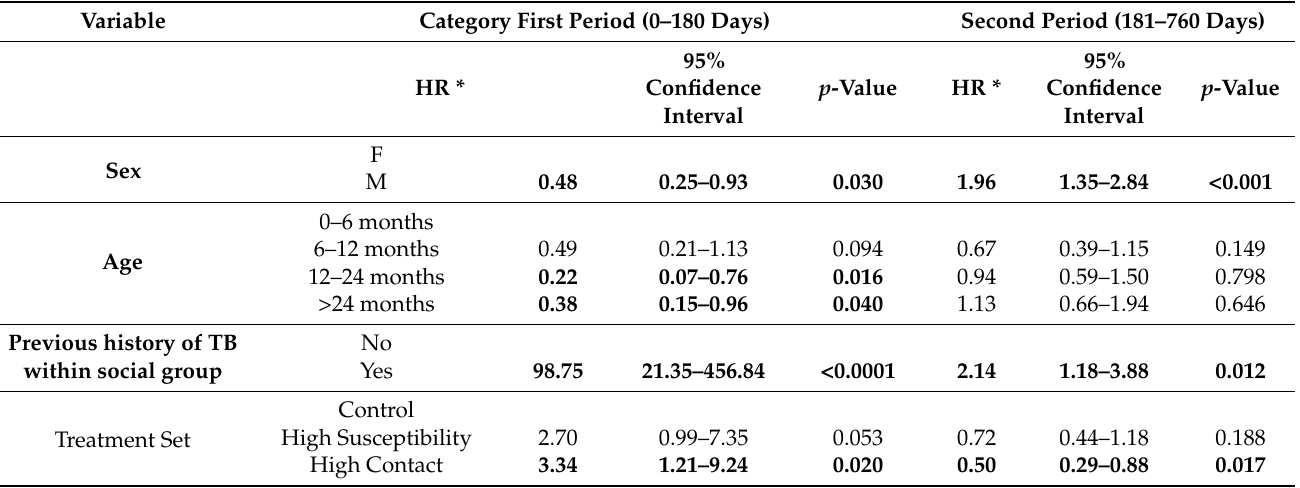
Table 3. Multivariable analysis results for survival time to death in 306 wild meerkats. Data are presented for two time periods; the first 6 months of the project, and the subsequent 18